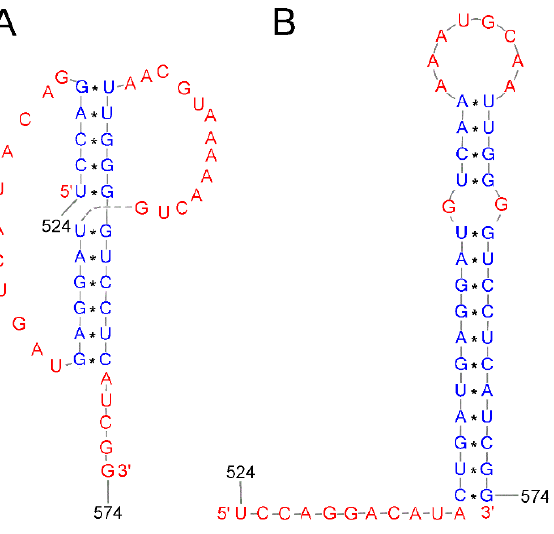
Figure 5. Pseudoknot ( A ) and hairpin ( B ) secondary structure of segment 8 (+) RNA of the IAV. Blue and red letter colors mark paired and unpaired nucleotides, respectively.